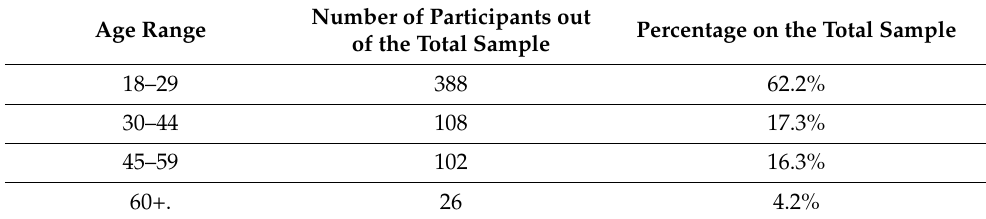
Table 1. Age distribution.